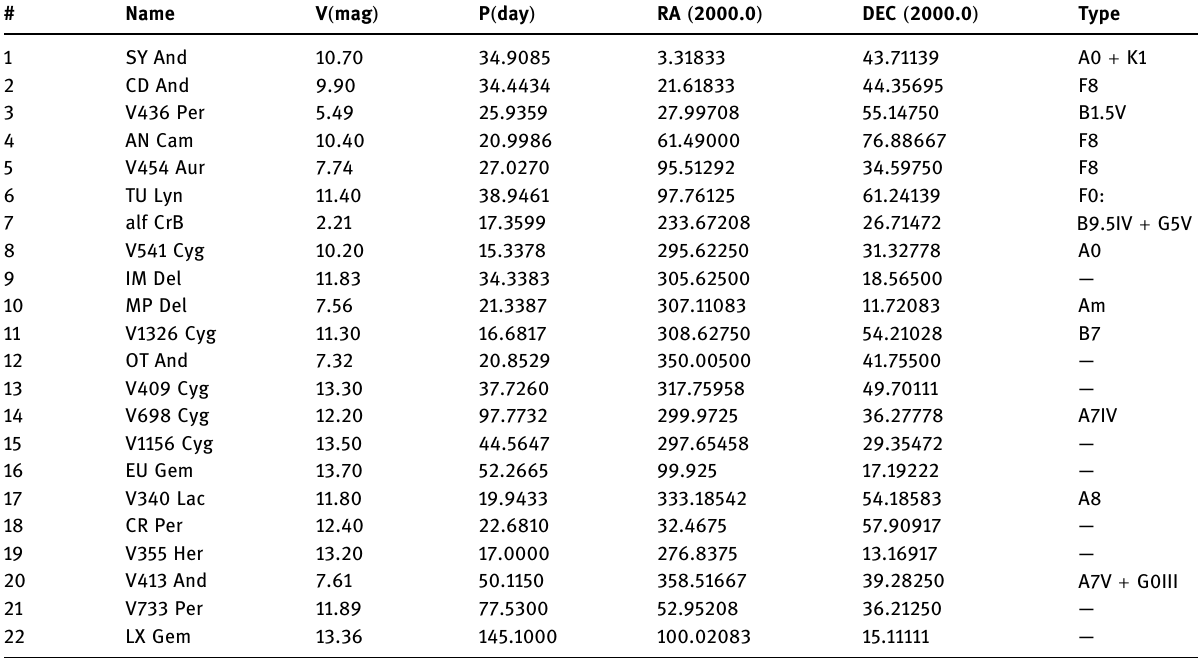
Table 1: List of stars in our sample – northern